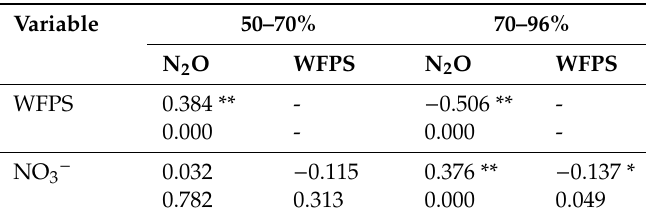
Table 8. Pearson’s correlation between the N 2 O emissions and WFPS and NO 3 − concentrations at WFPS of 50–70% and > 70% ( n =